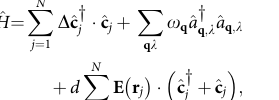
where we used that ^ J 2 ¼ J J þ 1 ð Þ ¼ 2 for the states under consideration. The quasiparticle dispersion near the nodes can be found by expanding the Hamiltonian in small momenta p ¼ k (cid:3) K . Momentum deviation from a node along the z axis leads to the splitting F [ K þ p z , ( K þ p z ) 2 , 2] ± o (cid:3) F [ K þ p z , 0, 2] between the intersecting branches. Using that K þ p ð